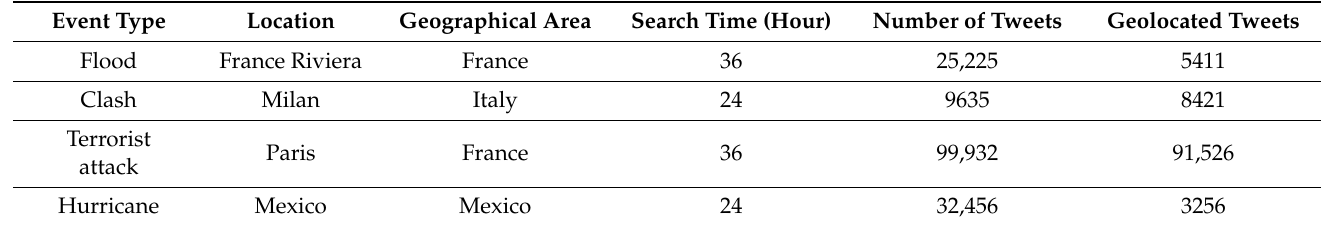
Table 2. Description of the considered events and the related parameters. First column indicates the name of the event, the second and third columns indicate, respectively, the location and the geographical areas, the fourth column the search time in hours, and the fifth and sixth columns indicate, respectively, the number of collected tweets containing images and the number of geo- located tweets with